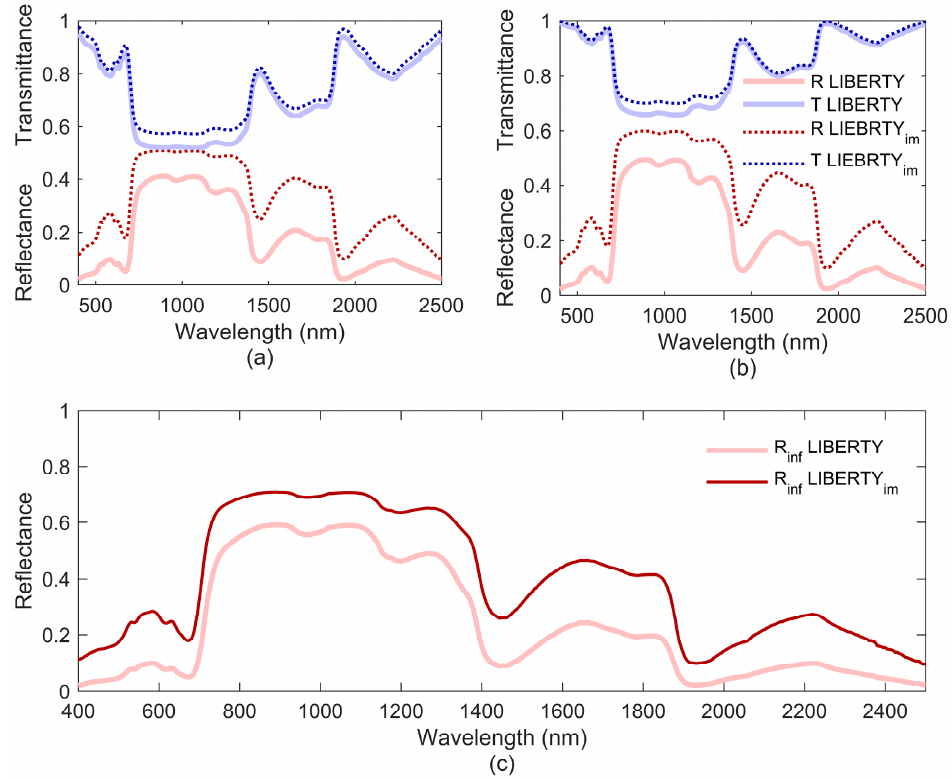
Figure 13. Comparisons of outputs from LIBERTY and LIBERTY im when the same input parameters were entered. ( a ) the sublayer reflectance and transmittance; ( b ) global reflectance and transmittance and ( c ) The infinite reflectance. The legend of ( a ) is given in ( b ). The input parameters i.e., the particle diameter d , the particle backscattering ratio x u , the number of sublayers N , baseline, the albino absorption, chlorophyll content (% dry matter), water content (% dry matter), lignin and cellulose content (% dry matter), protein content (% dry matter) were set to 40 µ m, 0.045, 1.6, 0.0005 µ m − 1 , 2 mg ∙ g − 1 , 200 mg ∙ g − 1 , 100 mg ∙ g − 1 , 40 mg ∙ g − 1 and 1 mg ∙ g − 1 , respectively. For LIBERTY im , the additional